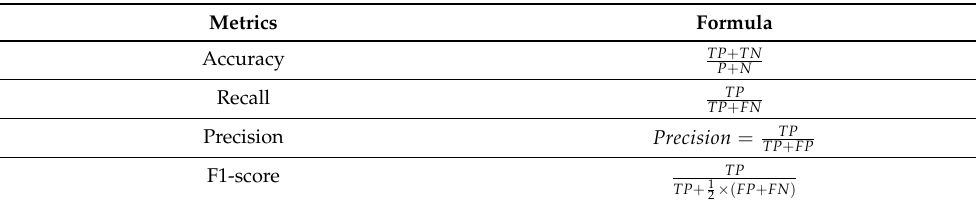
Table 6. Performance metrics for classification